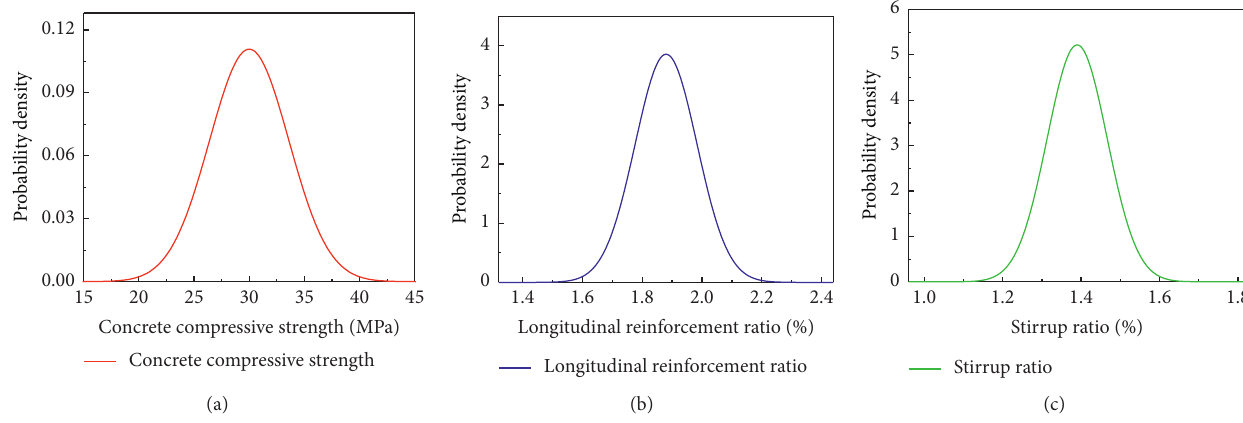
Figure 13: Probability density function: (a) concrete compressive strength, (b) longitudinal reinforcement ratio, and (c) stirrup ratio.